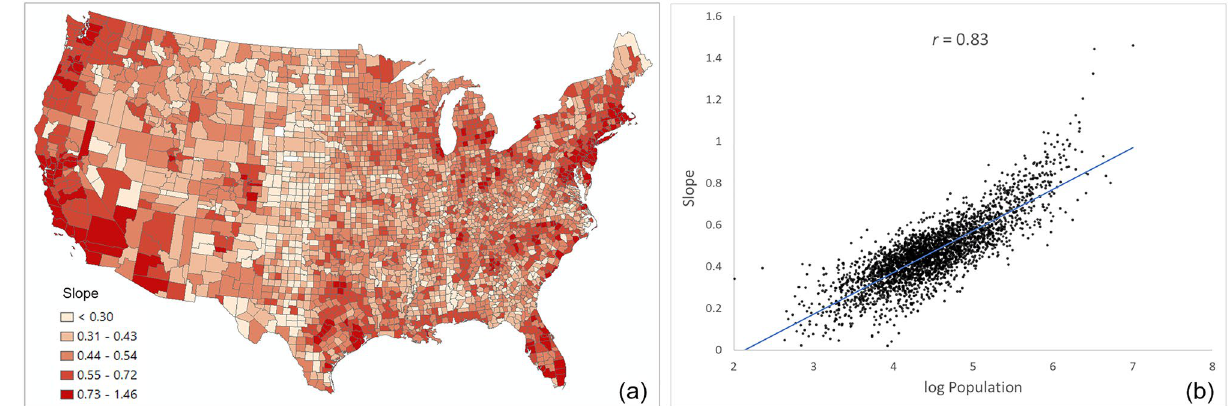
Figure 7. Examination of the hypothesis that same amount of change in friendships (SCI) is associated with a larger change in people’s movement (PCI) in more populated counties: ( a ) Distribution of the regression slope between log PCI and log Facebook SCI. ( b ) Correlation between regression slope and log county population for all counties. Population data were derived from ACS 5-year Data (2015–2019). The map was generated using ArcMap version